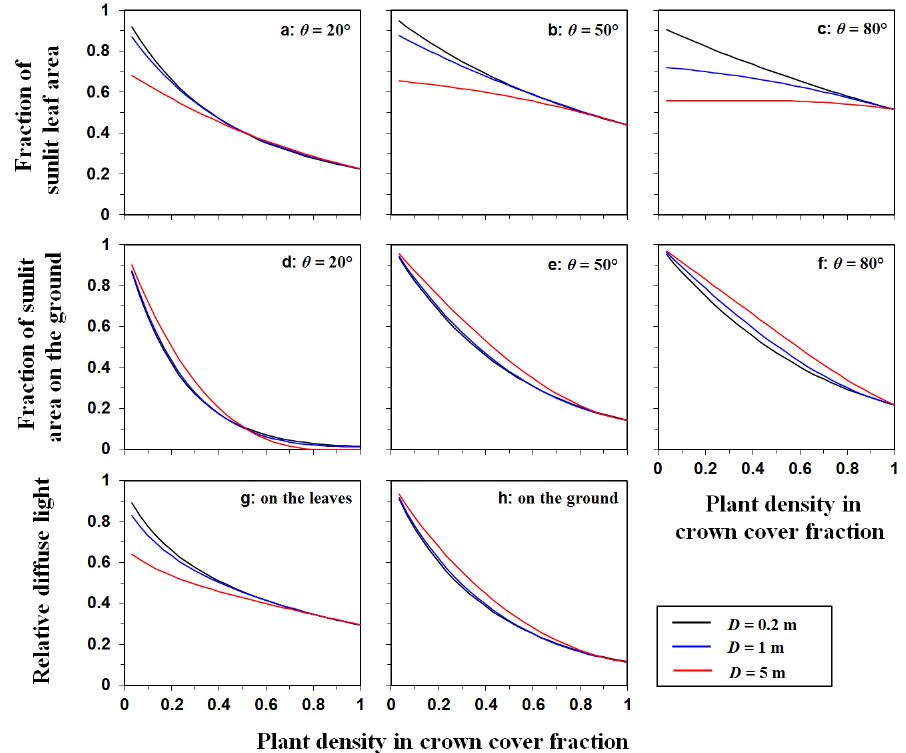
Figure 10. The sensitivity of the fractions of sunlit area (on the leaves and on the ground) and relative diffuse radiation to plant density and crown width. Plant density is expressed as crown cover fractions, calculated by D 2 d ( D is the width of the crown and d is the number of plants per square metre). The relative diffuse light is the ratio to the diffuse light on a horizontal surface above the canopy. The plant communities are composed of only one stratum ( h = 0m, H = 10m, LAI p = 3).